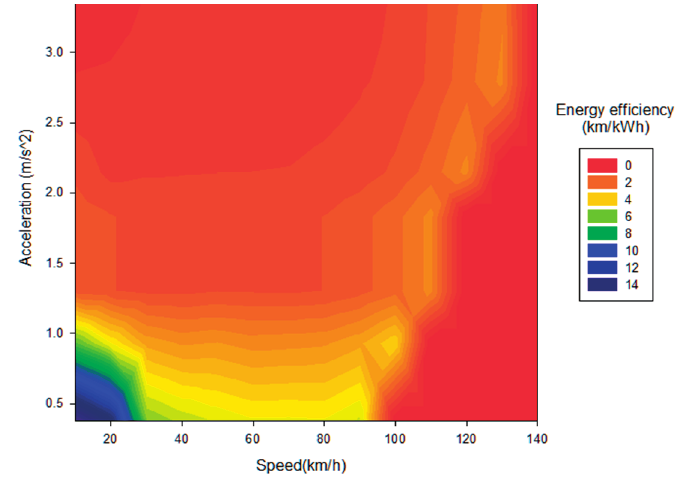
Figure 2. Energy efficiency according to vehicle speed and acceleration.